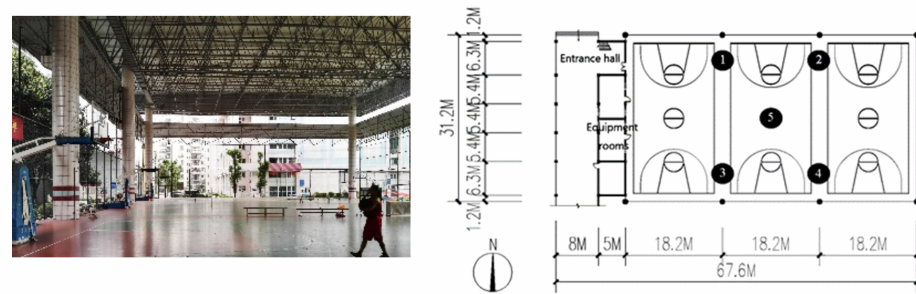
Figure 2. The interior view and plan of the measured gymnasiums (Points 1 (cid:13) to 5 (cid:13) represent the locations of the measuring